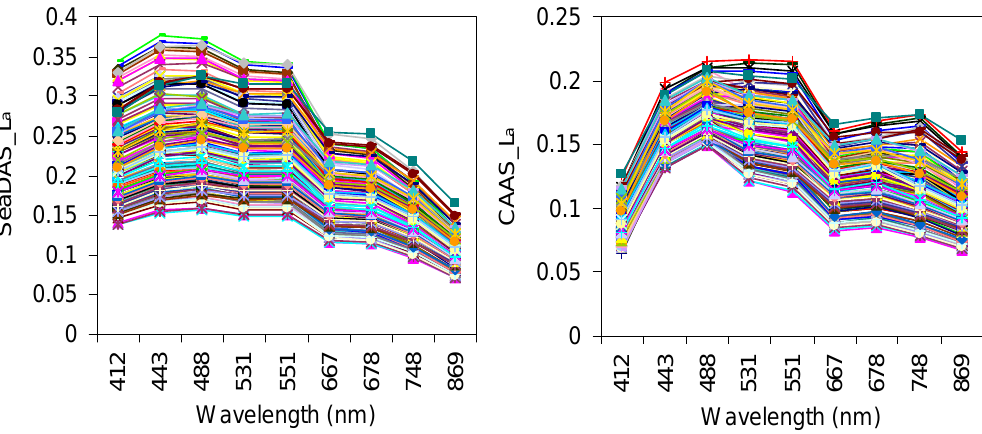
Fig. 7. Comparison of aerosol radiances derived from MODIS-Aqua imagery of bloomed waters of the Arabian Sea (18 February 2010) using the SeaDAS and CAAS algorithms. 1012